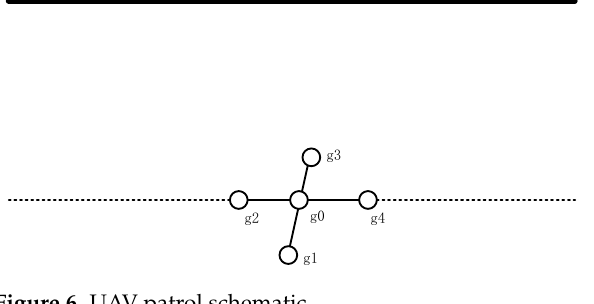
Figure 6. UAV patrol schematic.